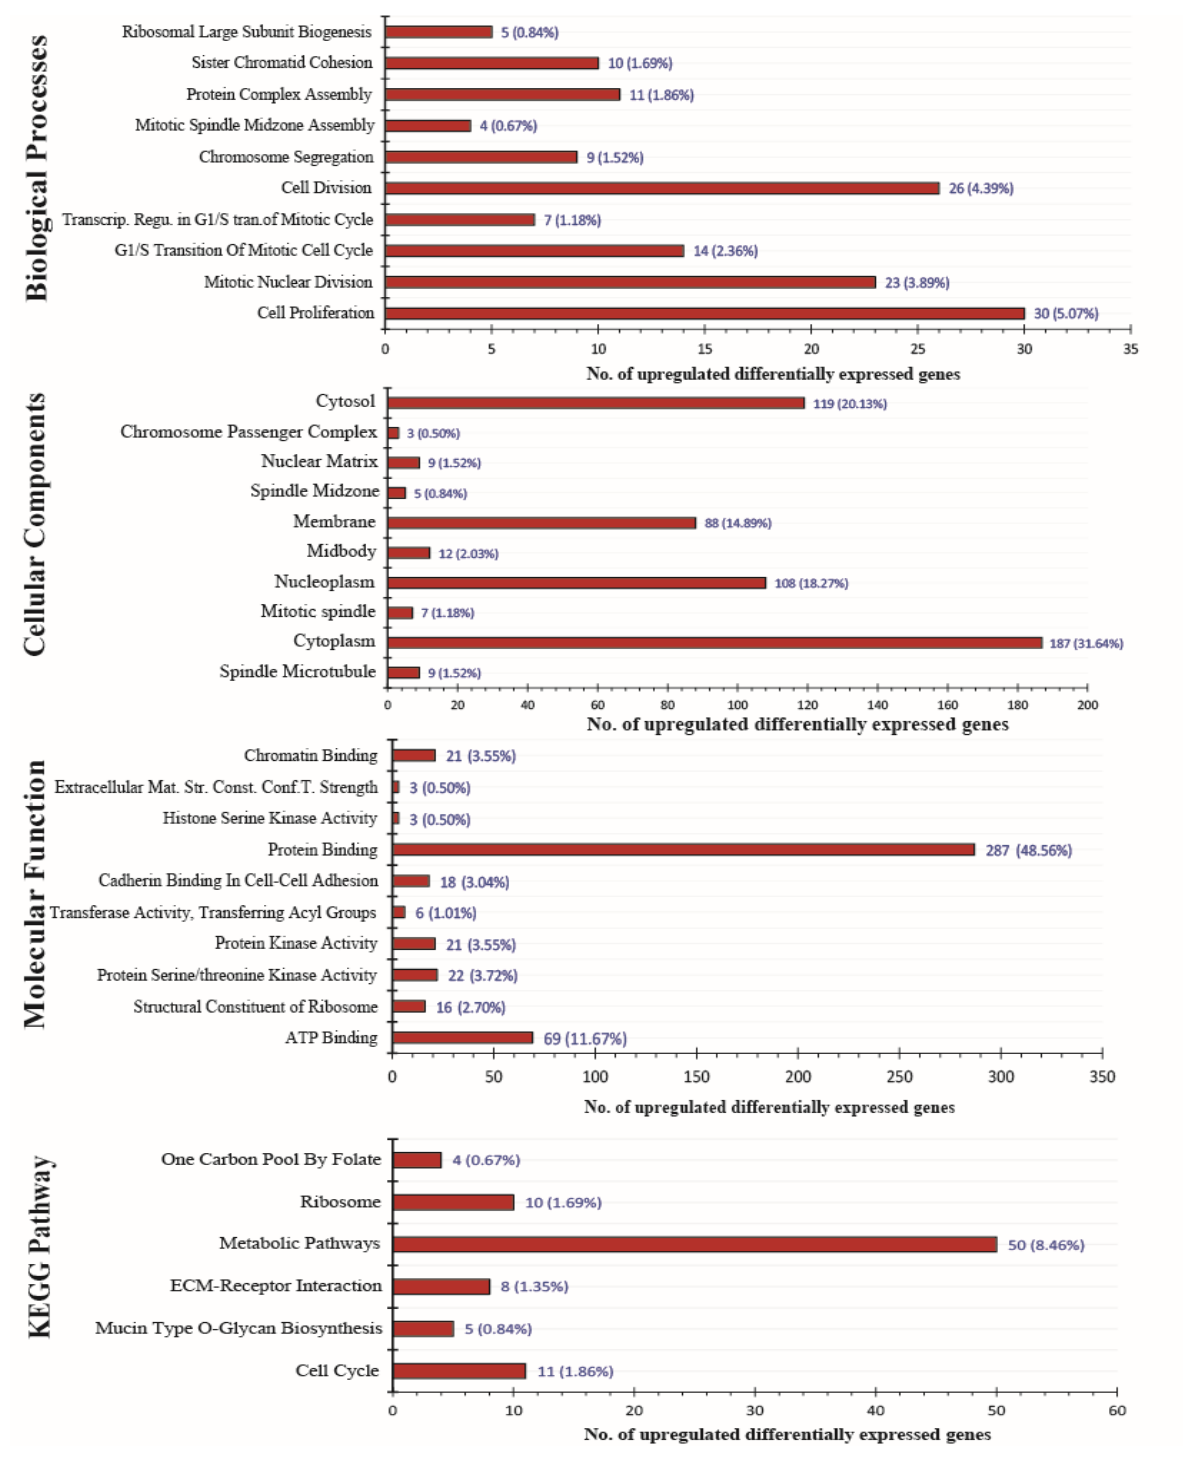
Figure 4. Gene ontology functional classification and pathway analysis of significant differentially expressed genes from various datafiles. Bar-graph of top most significant upregulated genes repre- senting biological process, cellular component, molecular function, KEGG pathway analysis. KEGG (Kyoto Encyclopedia of Genes and Genomes ).